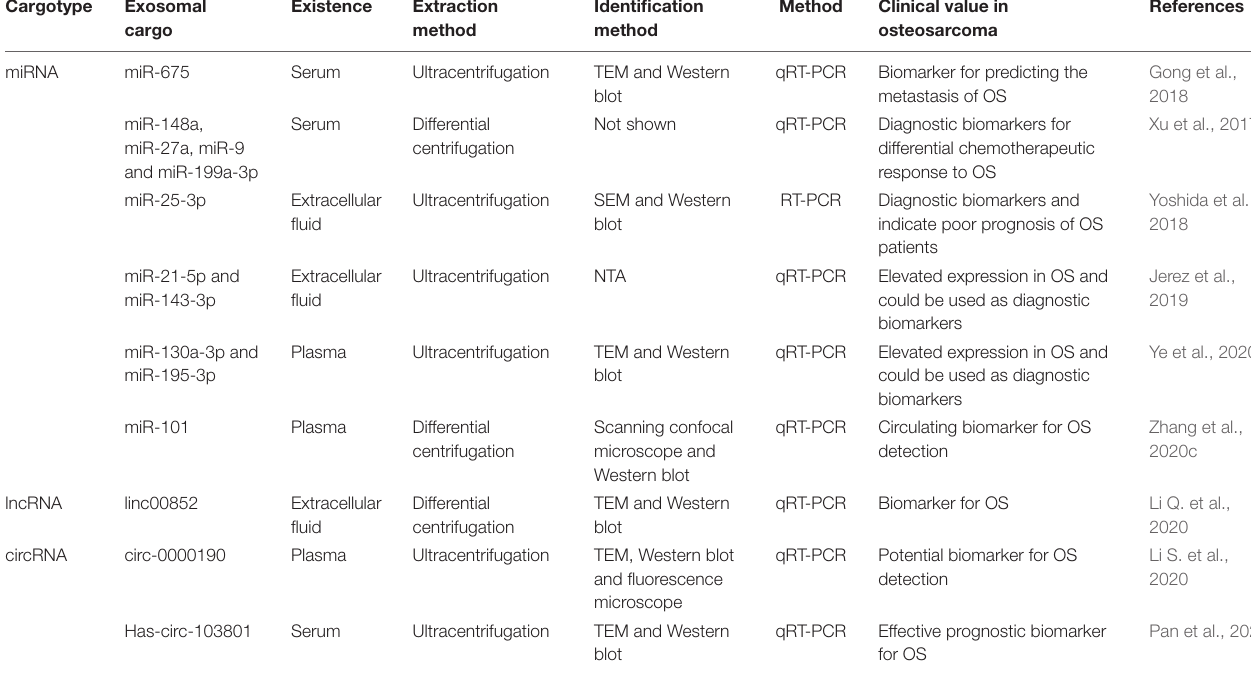
TABLE 2 | Exosomes extracted from biofluids as diagnostic and prognostic biomarkers for